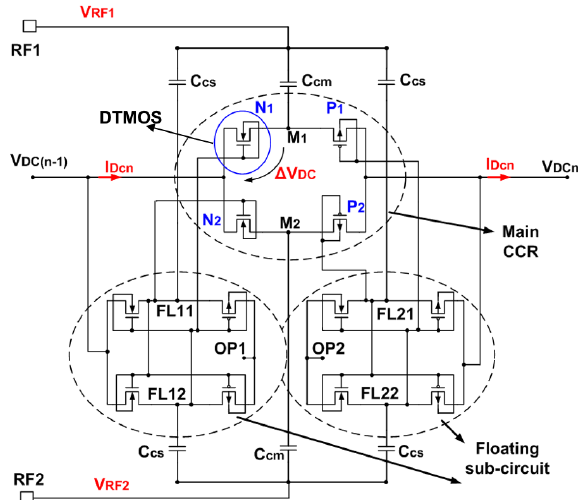
Figure 3. Dynamic threshold MOSFET (DTMOS) cross-coupled rectifier with floating sub-circuits.